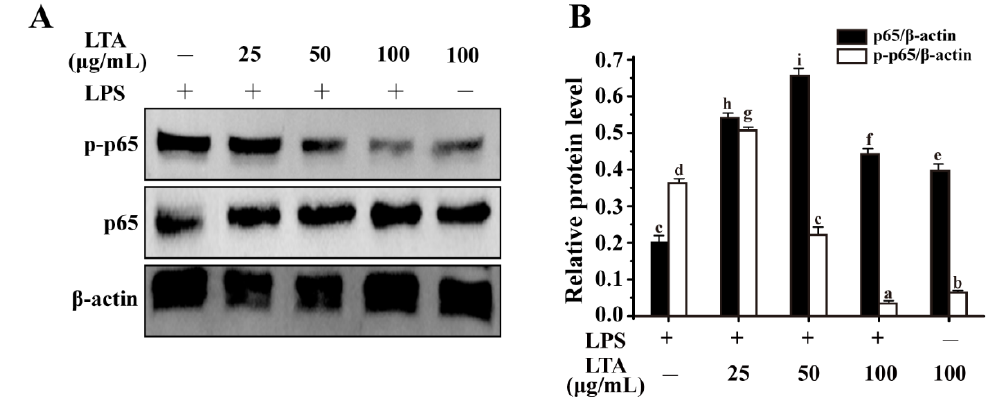
Figure 5. LTA suppresses NF- κ B signaling in LPS-induced RAW264.7 cells. ( A ) Phosphorylation of p65 was detected by Western blotting. ( B ) Relative protein levels meant the phosphorylation of p65 expression was relative to β -actin and p65 expression was relative to β -actin. Values with the different letters are significantly different, while same letters indicate no significant difference among the tested strains (Duncan’s test, p < 0.05). “+” and “ − ” mean RAW264.7 cells treated with or without additional LPS or LTA.